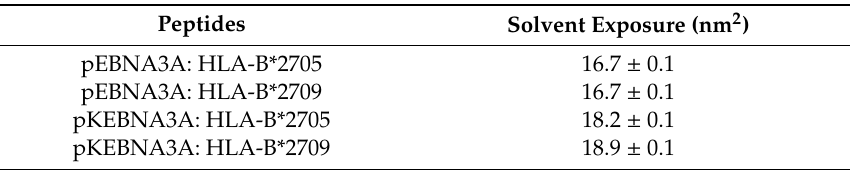
Table 3. Peptide solvent